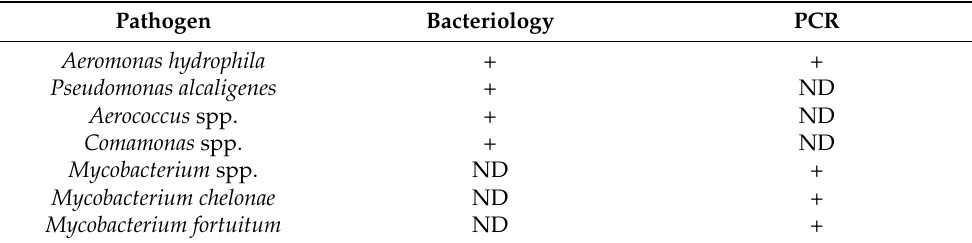
Table 4. A summary of the positive results in our health